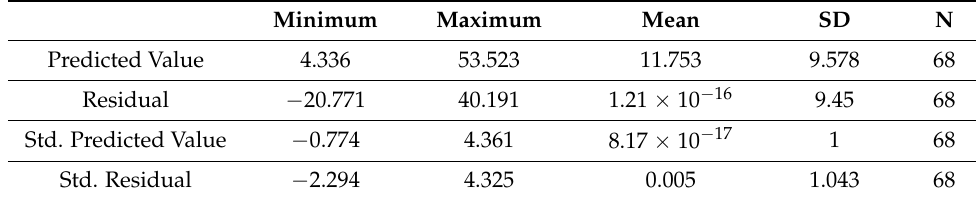
Table 12. Wet candle method and horizontal dry plate method—statistic of